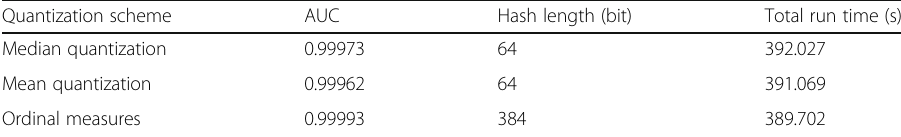
Table 6 Performance comparison among different quantization schemes Quantization